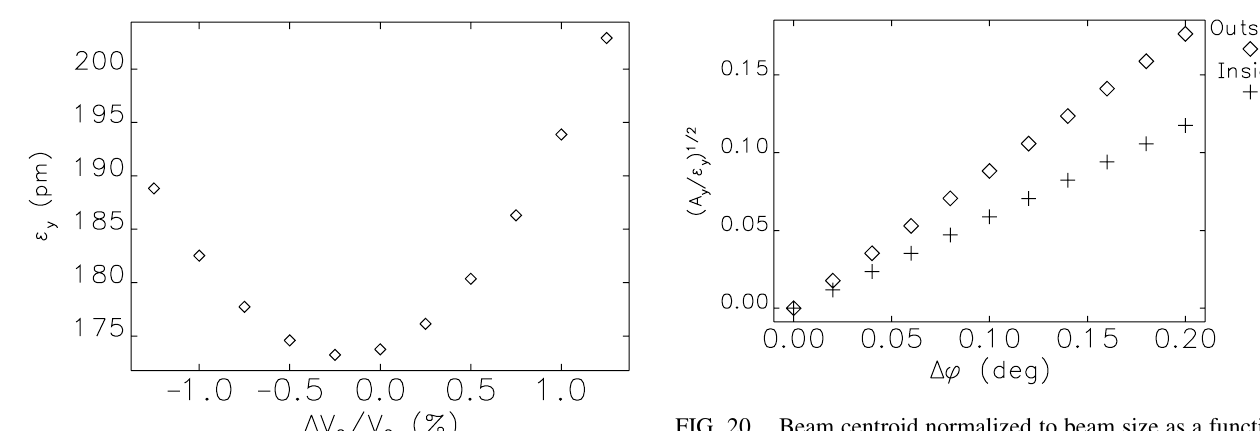
FIG. 20. Beam centroid normalized to beam size as a function of differential phase error between the crab cavities, for h (cid:3) 8 and V (cid:3) 4 MV .FIG. 19. Variation of the vertical emittance for h (cid:3) 8 and V (cid:3)